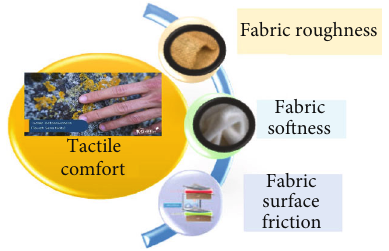
Figure 2: Factors a ff ecting tactile comfort.